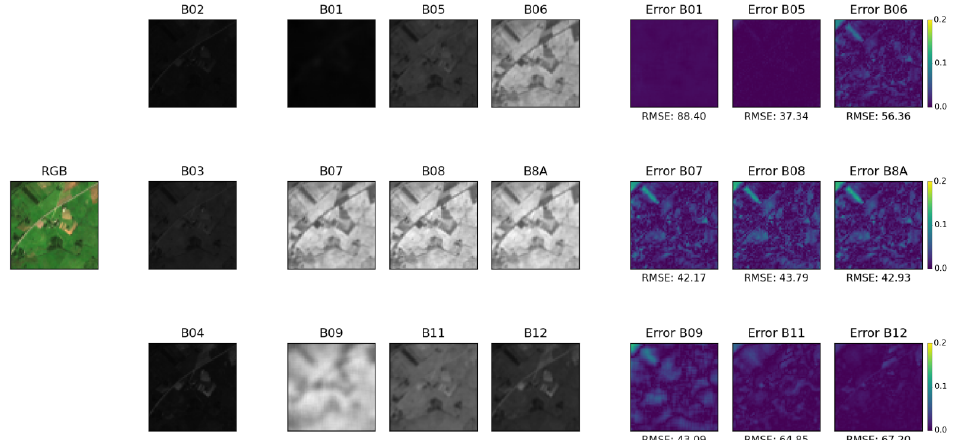
Figure 11. Error map as the absolute error between the each spectral band of a multispectral image of pasture and the reconstructed image. From left to right by columns: RGB composite, red, green and blue channels, spectral reconstruction, error map. To improve the visual inspection of the error, the scale has been adjusted between 0 and